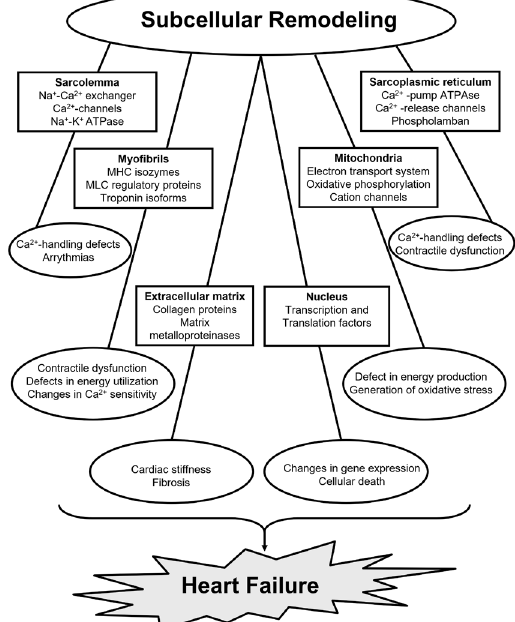
Figure 1 . Subcellular targets, sites affected, and functional abnormalities in cardiomyocytes during the development of heart failure. MHC: myosin heavy chain; MLC: myosin light